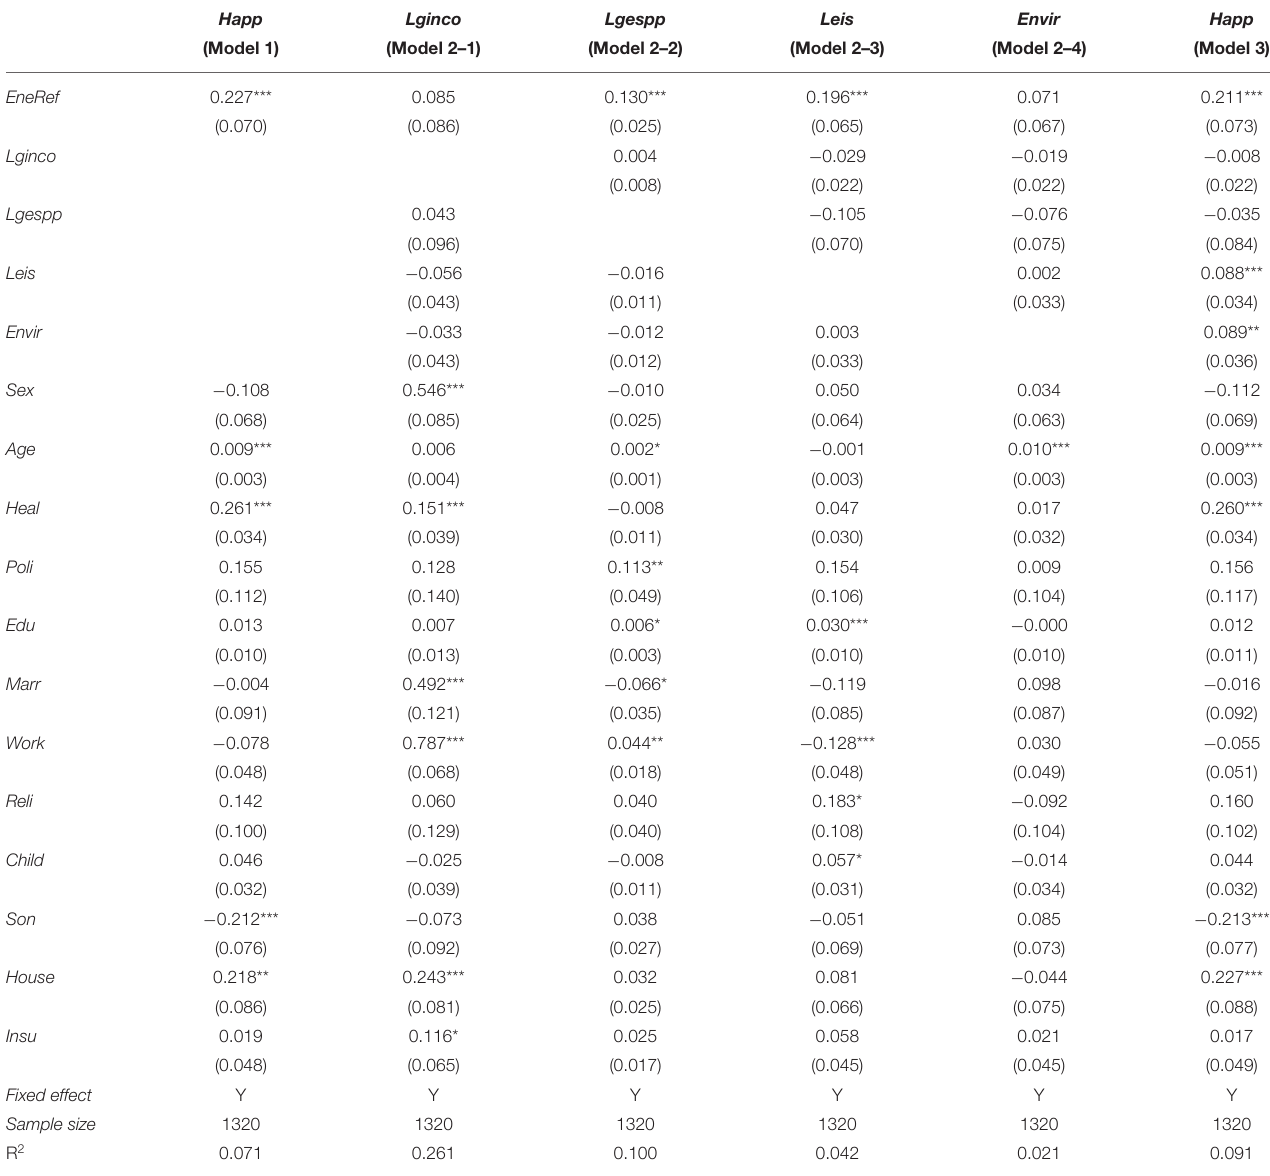
TABLE 2 | Benchmark regression results of the mediation